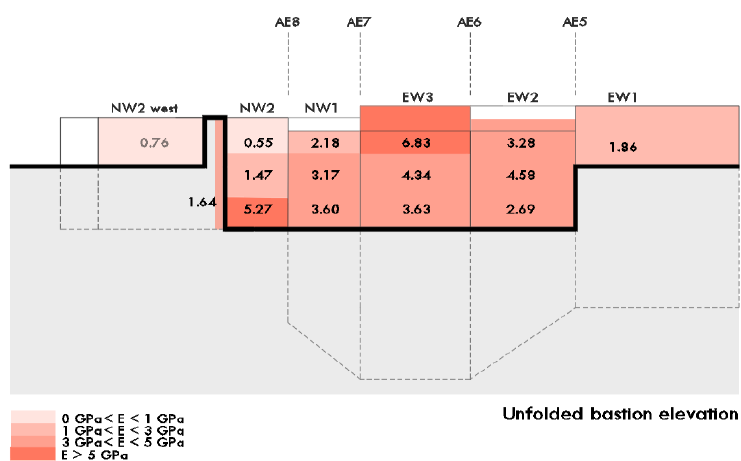
Figure 12. Location of non-destructive tests carried out at the tower.